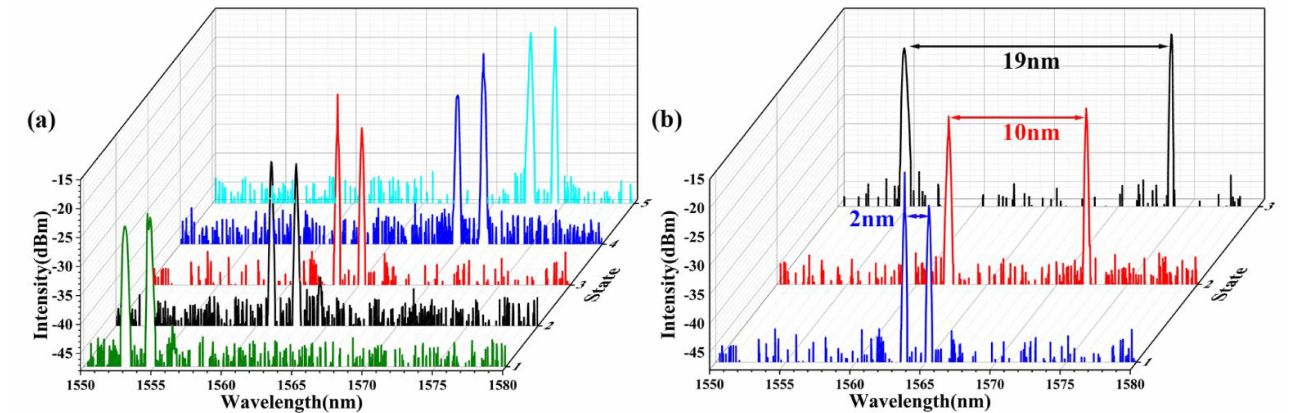
Figure 3. The dual-wavelength STML state with different pulse patterns: ( a ) the spectrum, inset: beam spot; ( b ) the whole pulse-train; ( c ) the filtered pulse-train at 1551.58 nm, and( d ) the filtered pulse-train at 1562.12 nm.